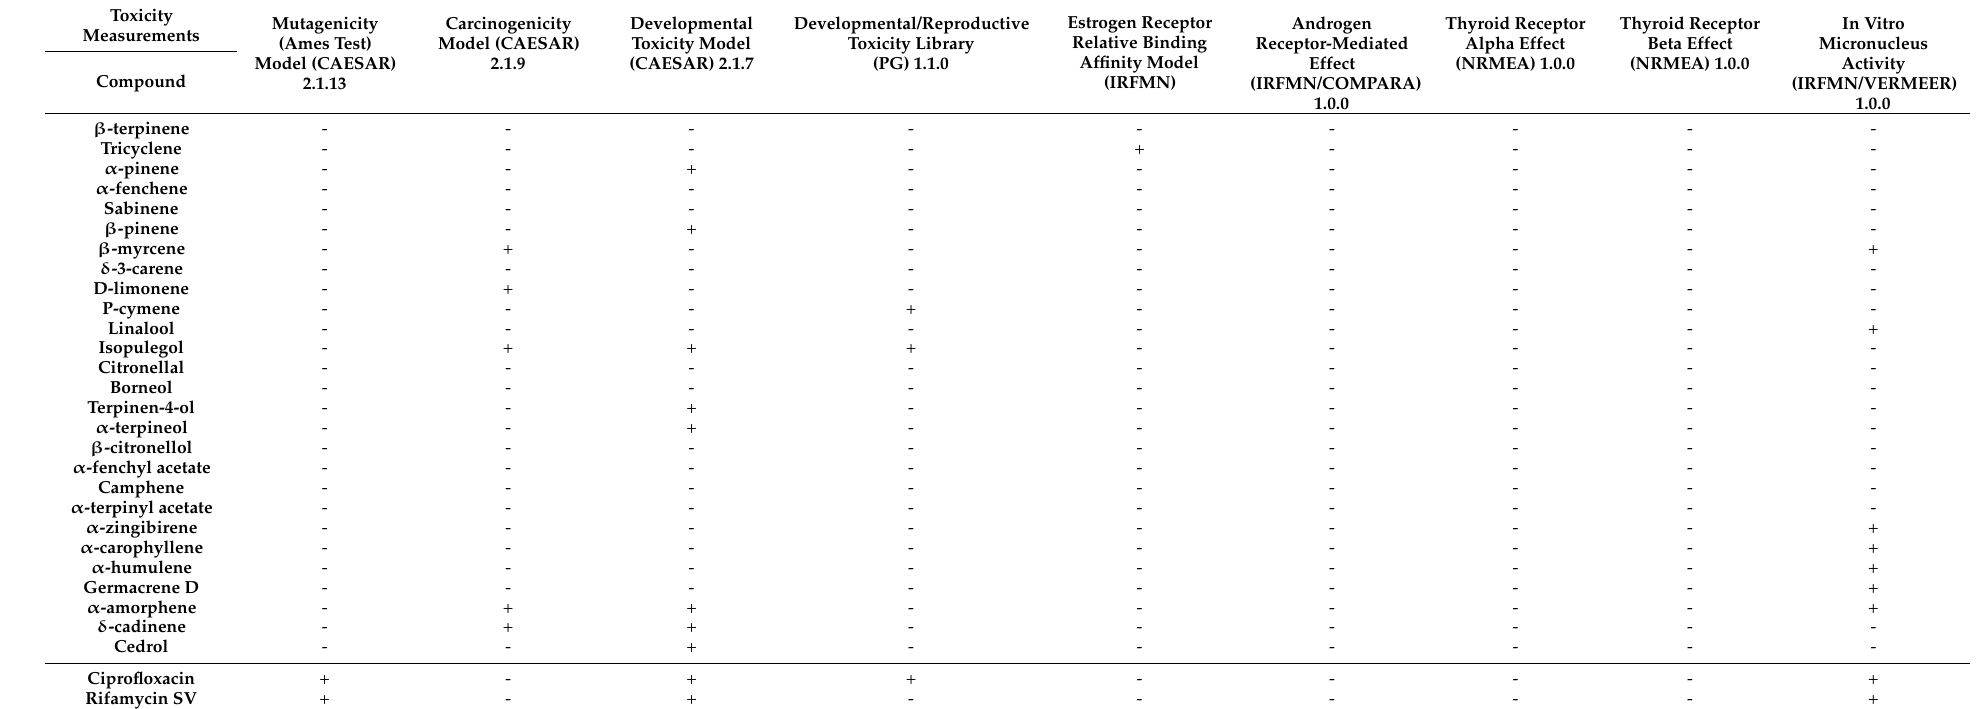
Table 3. Toxicity predictions of (CSEO) compounds and selected antibiotics using Vega QSAR